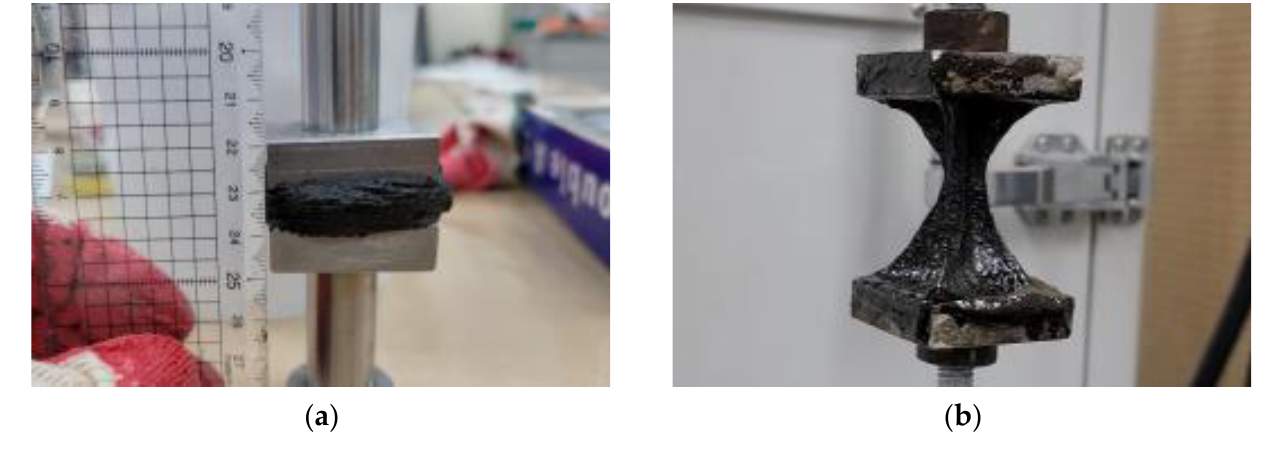
Figure 8. Cohesion strength testing for 10 mm specimen; ( a ) specimen thickness measurement, ( b ) cohesive strength testing. Table 4. Measurement result based on specimen types (10 mm thickness).